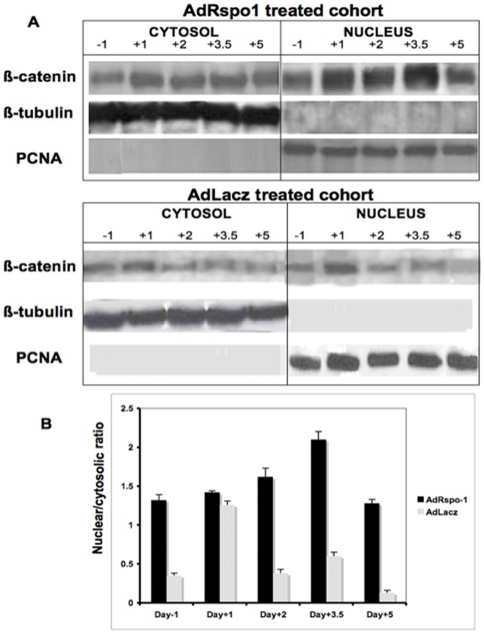
AdRspo1 treatment induces β-catenin activation in irradiated crypts.Representative immunoblot (Fig. 7A) and densitometric analysis (Fig. 7B) of nuclear/cytosolic ratios of β-catenin from AdRspo1 and AdLacZ treated cohorts after WBI(10.4Gy). Nuclear fraction purity was validated by the absence of β-tubulin, while the purity of the cytosolic fraction was evaluated by the absence of PCNA (Fig. 7A). A continuous decline in nucear/cytosolic ratios of β-catenin was predominate in samples from irradiated AdLacZ cohorts. This is further supported by the densitometric analysis of β-catenin expression (Fig. 7B) from the nuclear/cytosolic ratio demonstrating the significant differences in AdRspo1 when compared to AdLacZ treated mice prior to (Day –1) until Day +5 post WBI.